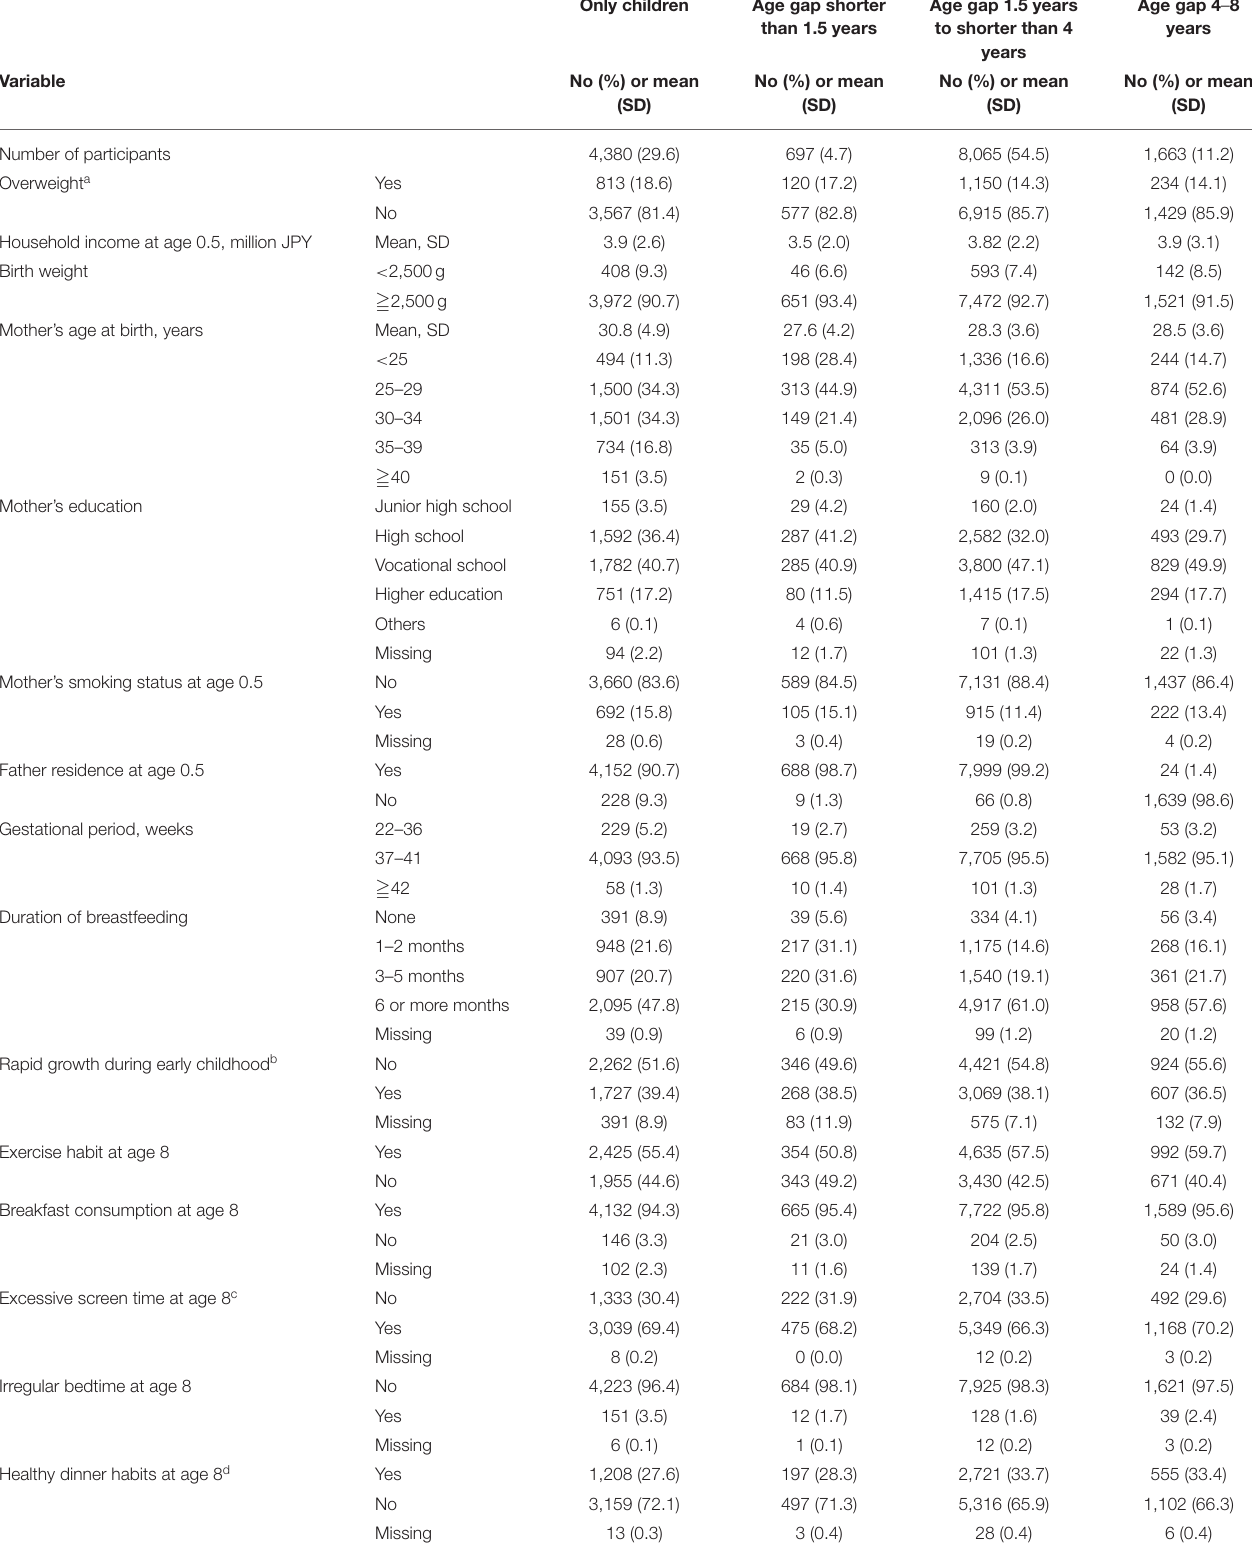
TABLE 1 | Characteristics of study participants from the Longitudinal Survey of Newborns in the 21st Century, 2001–2009 (total n =